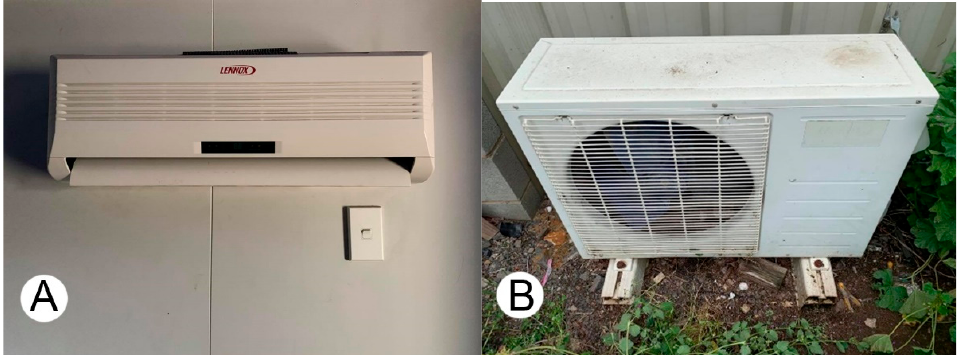
Figure 2. Split systems air conditioner: ( A ) Indoor unit—Evaporator; ( B ) Outdoor unit—Conden-